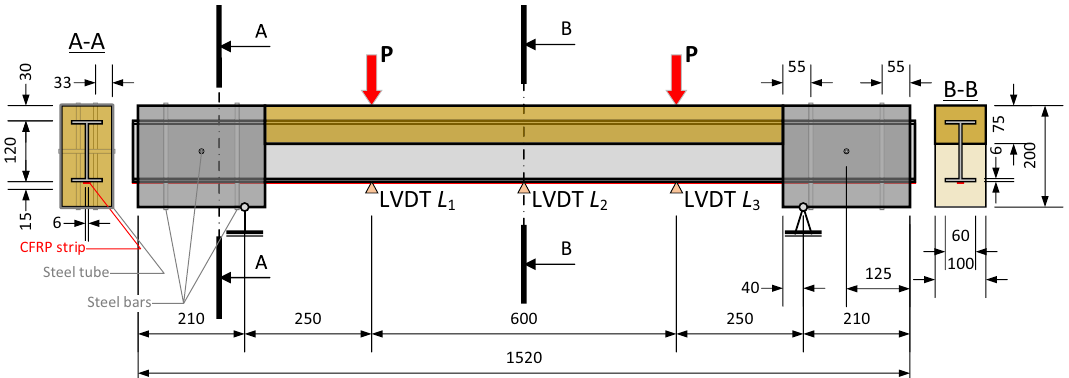
Figure 3. The updated hybrid beam schematic and modified cross-sections.